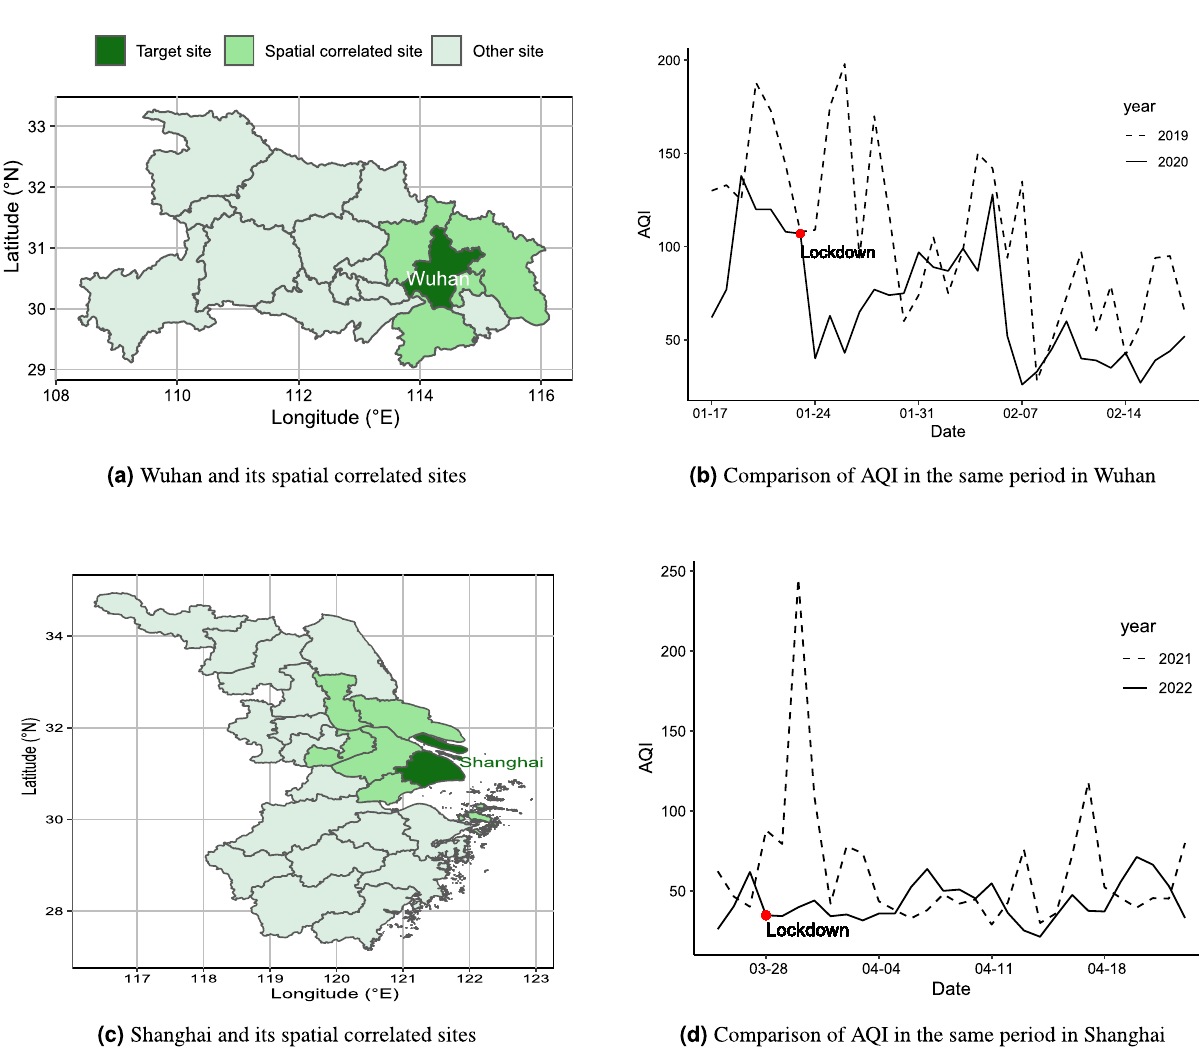
Figure 4. The study area and the variation of